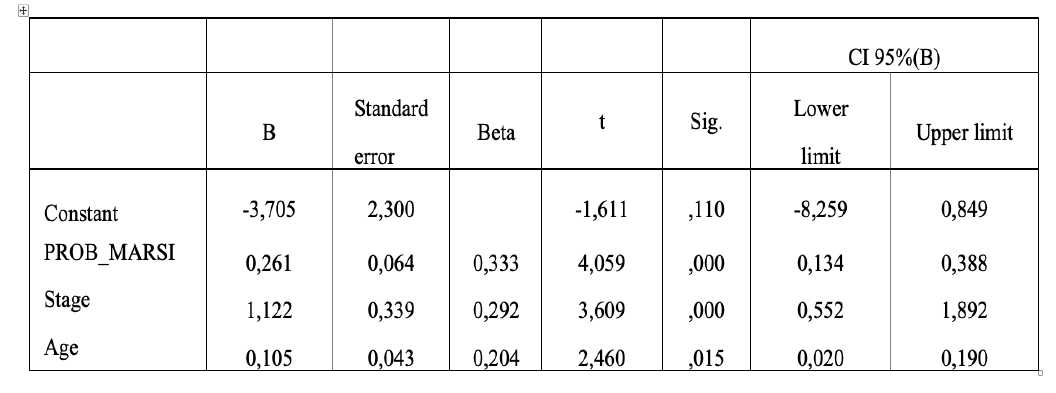
Table 8. Coefficients in the multiple linear regression model (stepwise